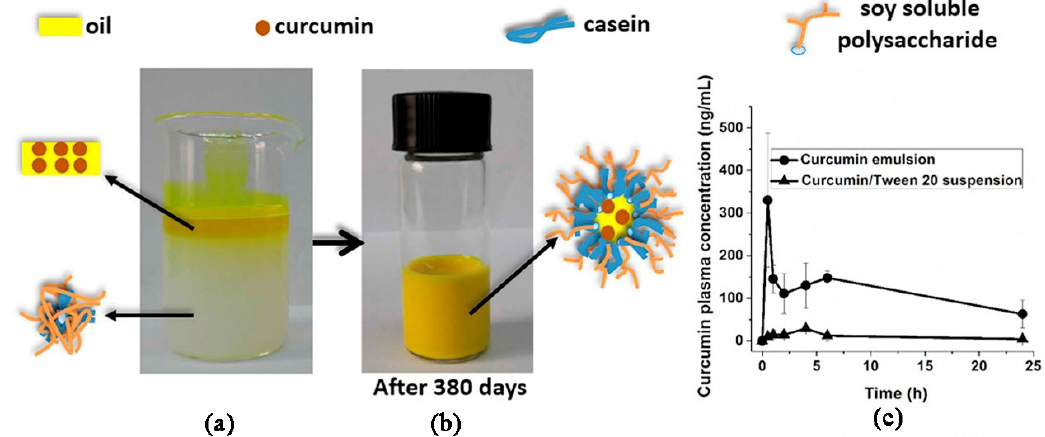
Figure 4. Diagrammatic representation of formation of SSPS-casein complex ( a ), the stabilized emulsion with a long-term stability ( b ), and the significantly improved loading and bioavailability of SSPS-casein stabilized curcumin emulsion compared to that stabilized by Tween 20 (c) [56].